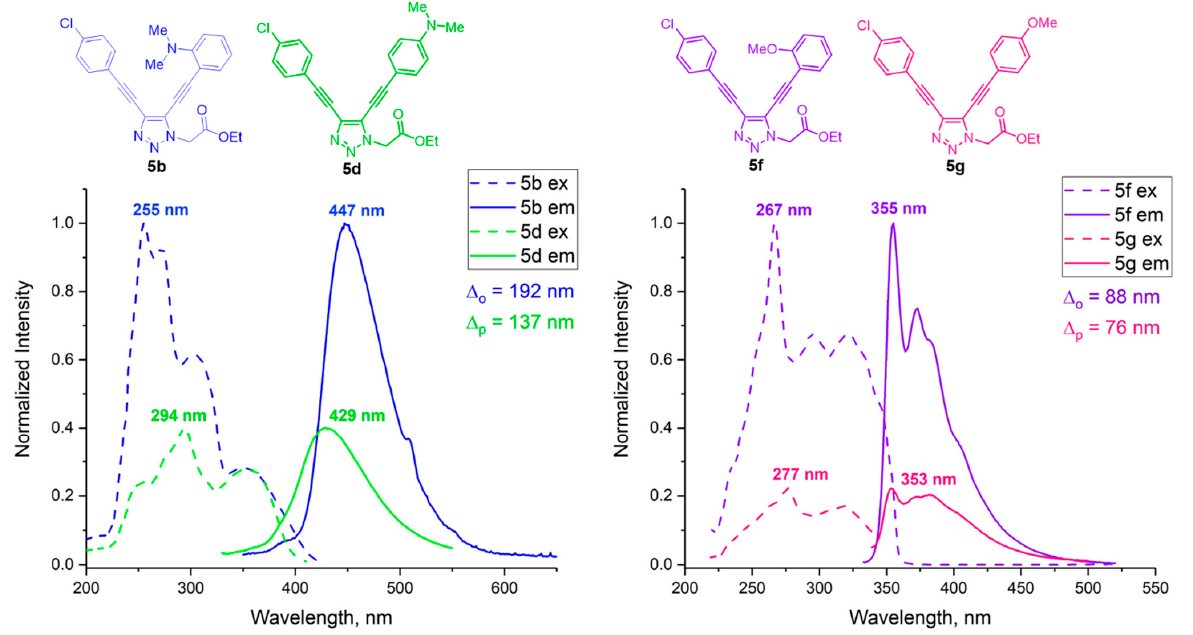
Figure 4. Dependence of the fluorescence intensity of triazoles 5b / 5f and 5e / 5h’ on the position of the EDG ( ortho - or para -) at C5-phenylethynyl unit.